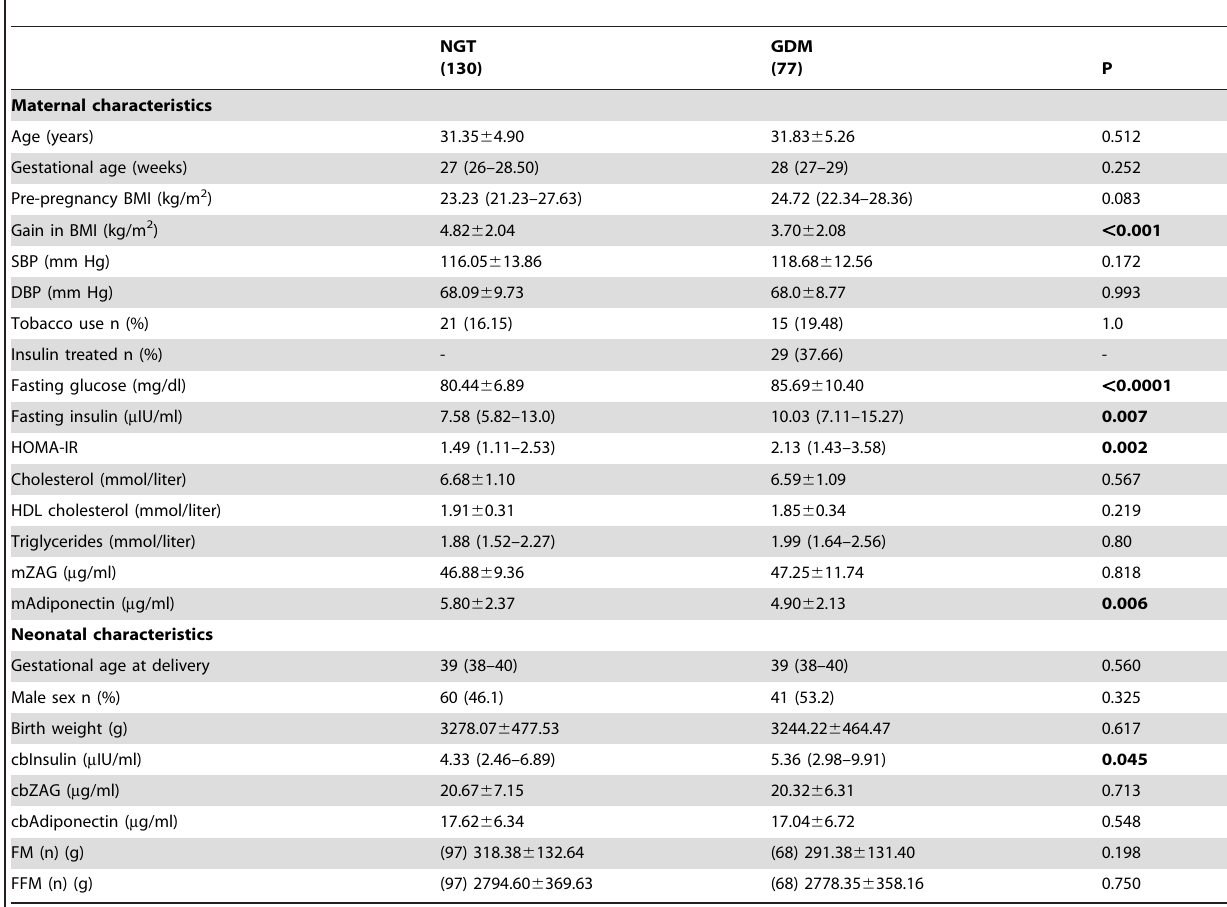
Table 1. Clinical and metabolic characteristics of the population